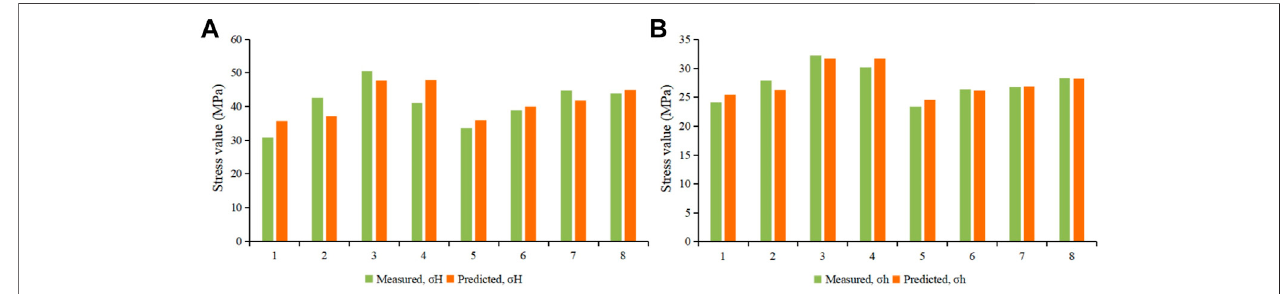
FIGURE 11 | Calculated and measured results of the in-situ stresses of some fracturing intervals in the study area. (A) σ H ; (B) σ h .